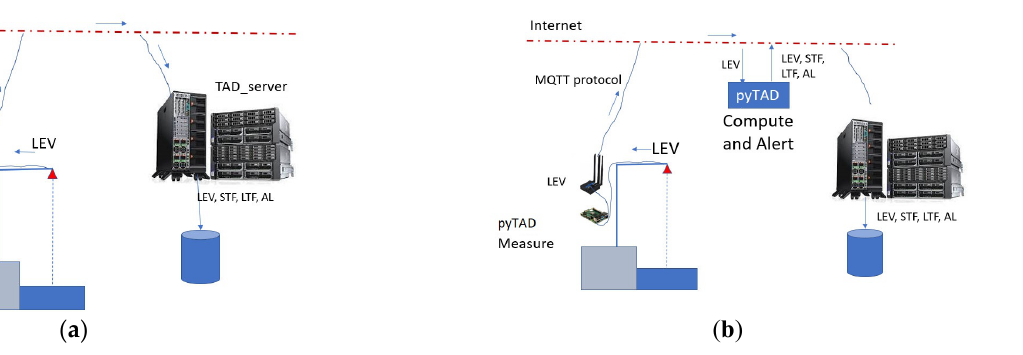
Figure 11. Different implementation of the algorithm computation schemes. ( a ) IDSL scheme: measurements, calculations and alerts performed on site; ( b ) generic sea level with push capability: calculations and alerting performed at the receiving server.